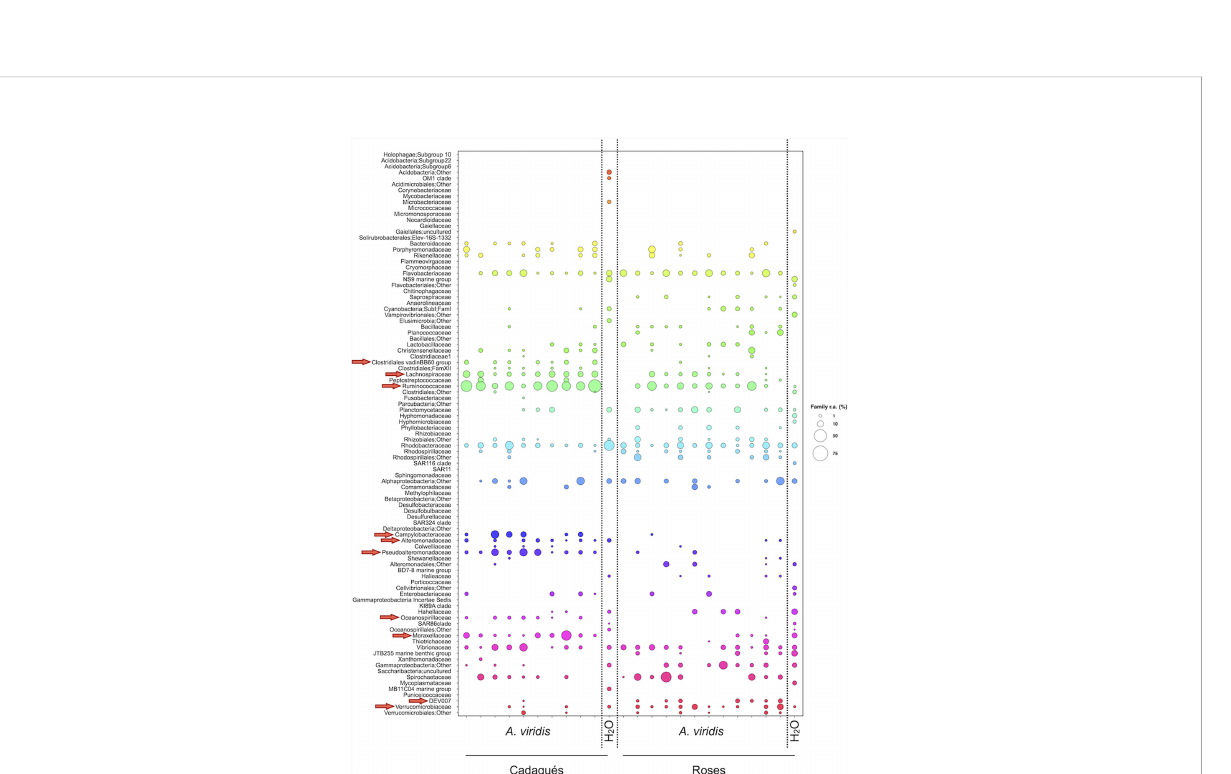
FIGURE 7 Metacommunity bubble plot at the family level in the Cap de Creus site. Bubble plot of the compositional structure of Cadaque ́ s and Roses A. viridis microbiota samples compared with the respective surrounding seawater at the Cap de Creus site. A. viridis microbiota components showing a differential distribution between Cadaque ́ s and Roses samples according to the MaAsLin2 model are indicated by red arrows. The size of the bubbles represents the percentage of relative abundance according to the legend on the